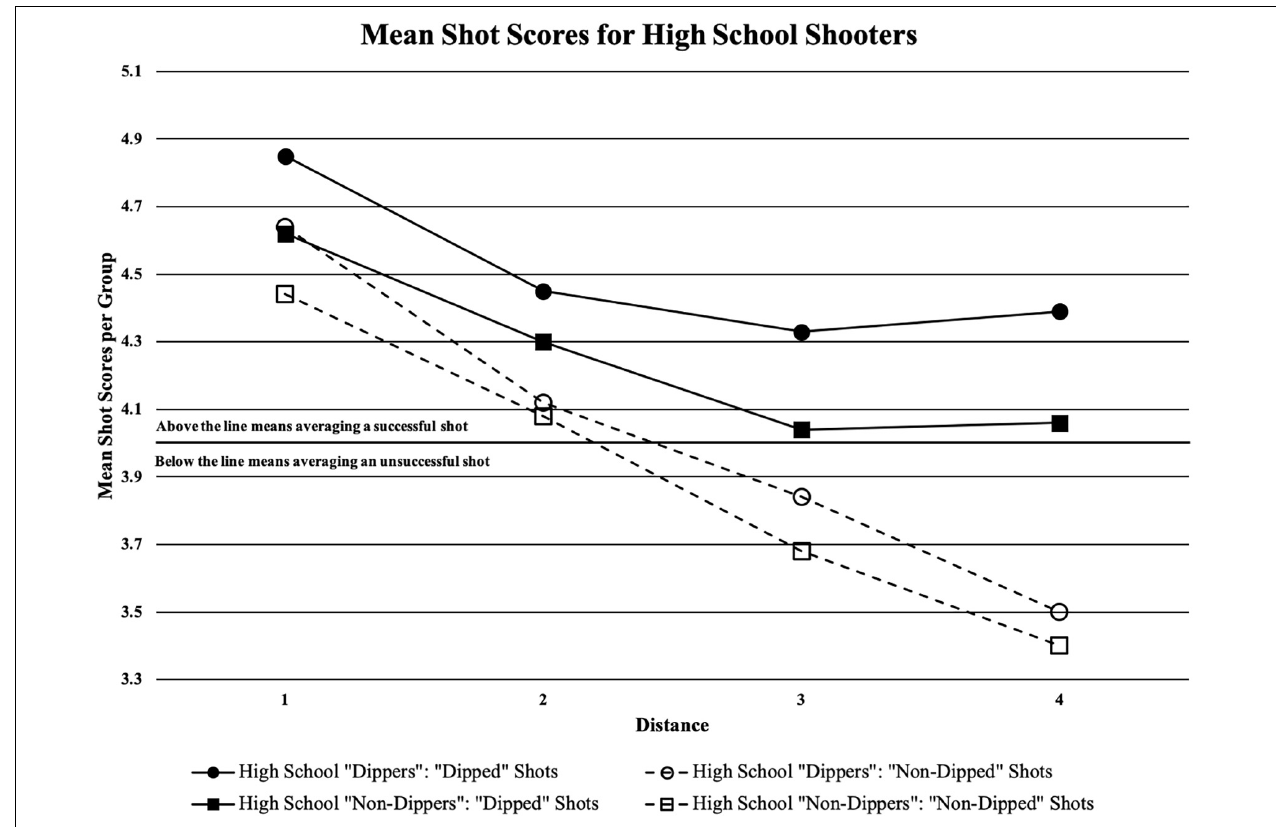
FIGURE 4 | Mean shot quality scores from each of the two shooter types (“dipped” or “non-dipped”) high school players at each of the four distances; black horizontal line is the cut-off point for when a certain group would be averaging a successful shot (if above the line) or averaging an unsuccessful shot (if below the